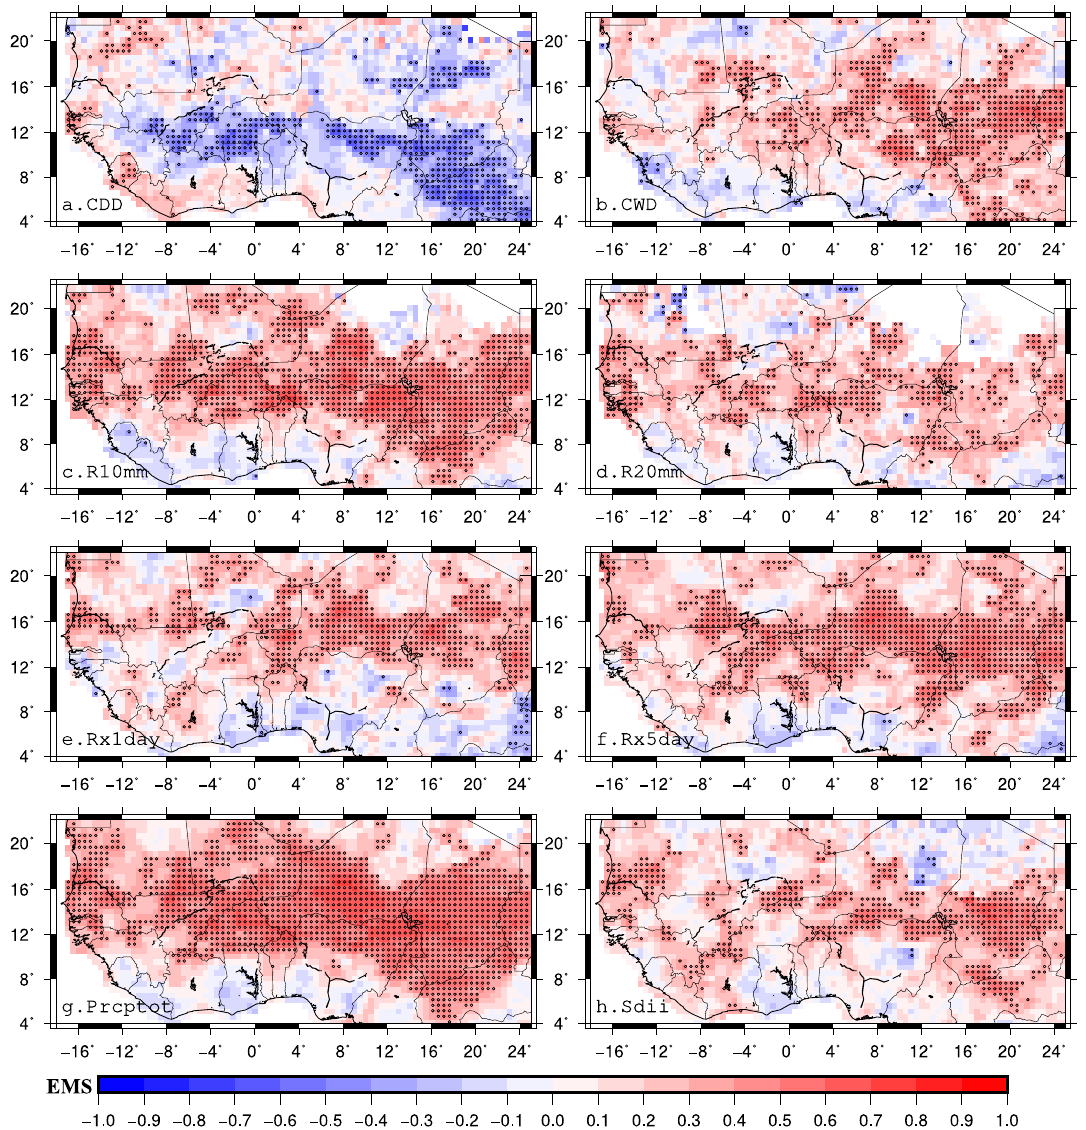
Figure 9. Correlation patterns between EMS and extreme precipitation indices. Tipping points represent significant correlation areas using EDOF. ( a ) CDD, ( b ) CWD, ( c ) R10mm, ( d ) R20mm, ( e ) Rx1day, ( f ) Rx5day, ( g ) Prcptot and ( h ) Sdii.